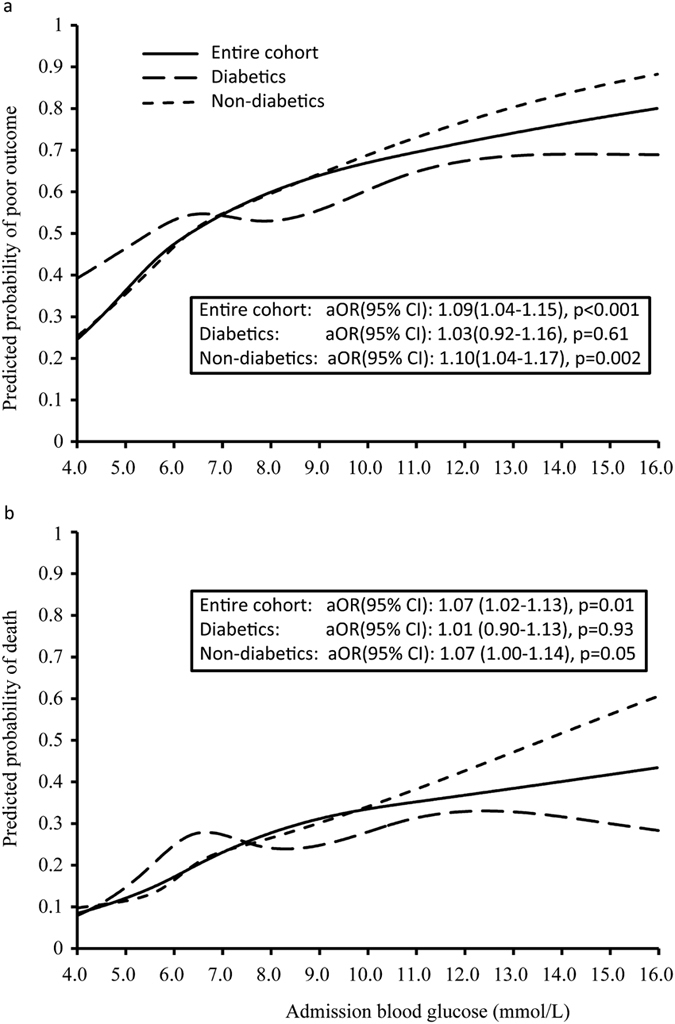
Predicted probabilities of poor outcome (a) or death (b) by admission blood glucose.